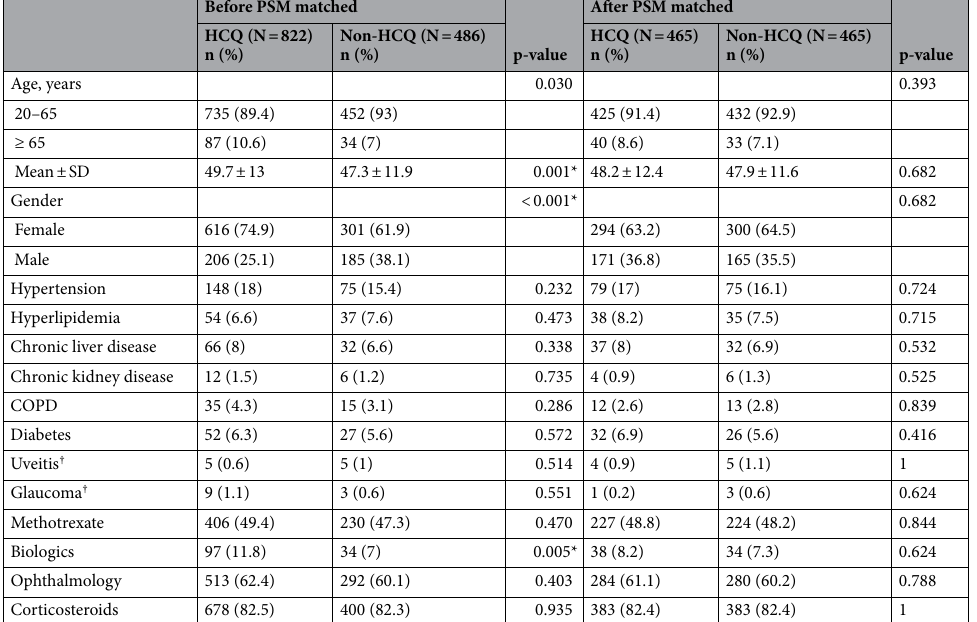
Table 1. Demographic characteristics of hydroxychloroquine users and non-users. † Fisher’s exact test. *p <